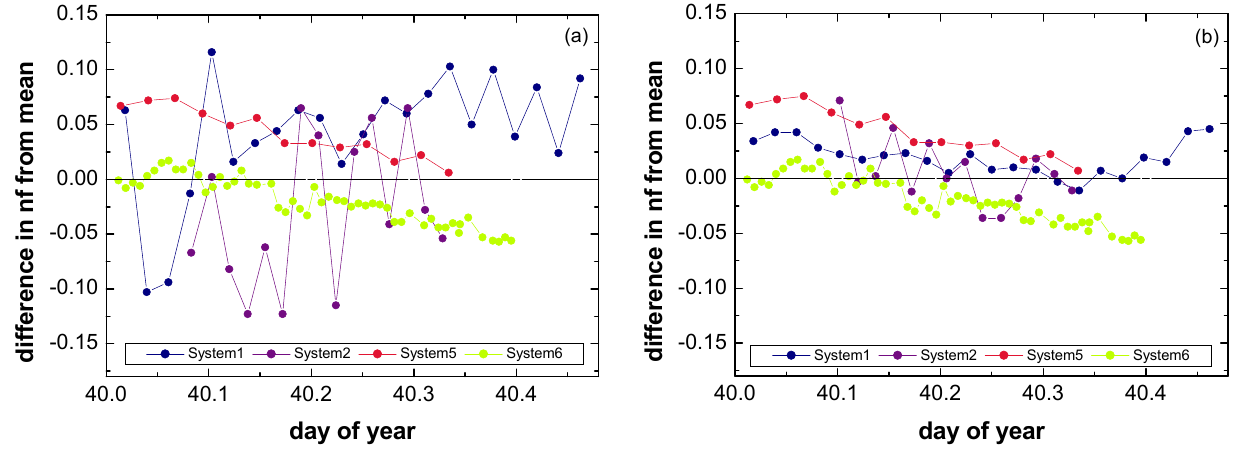
Fig. 8. Time series of (a) externally and (b) internally evaluated difference in number fraction from the mean value of less hygroscopic and more hygroscopic particles measured at a dry diameter of Dp =50nm and at